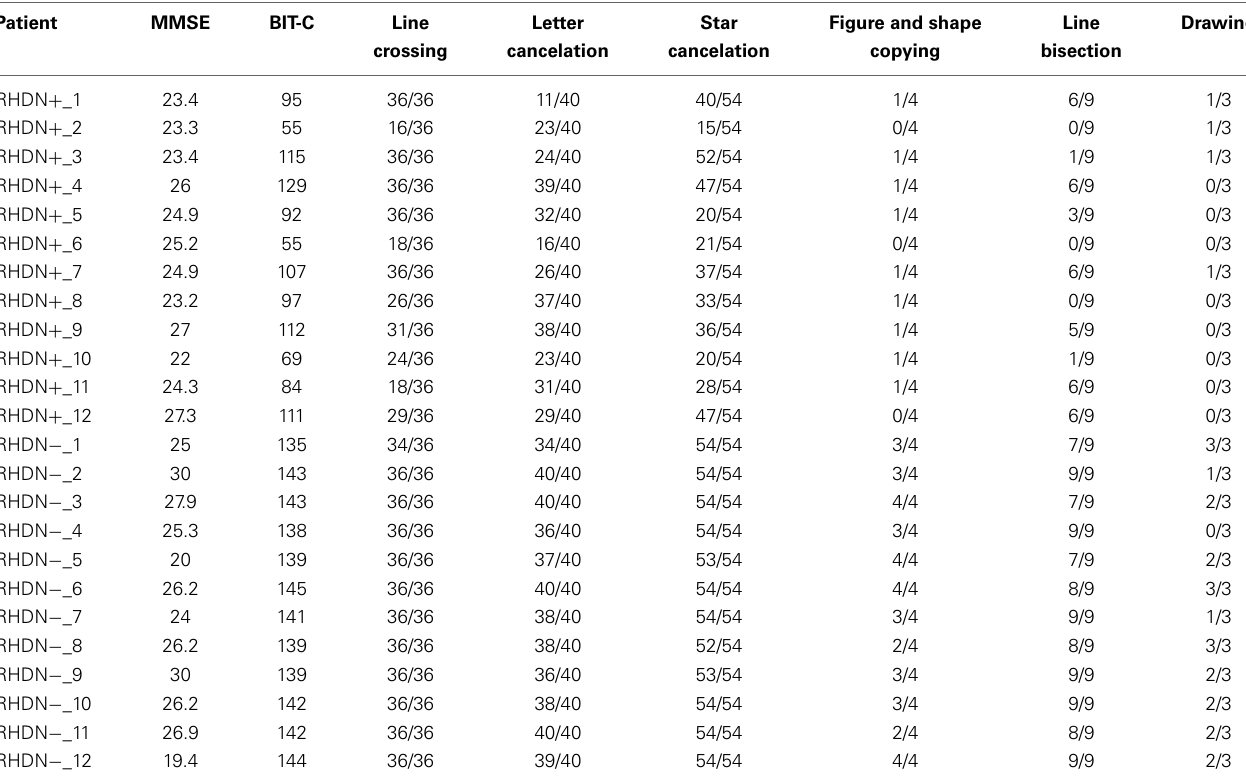
Table 2 | Patients’ performance on neuropsychological tests. Patient BIT-C Line Letter Star Figure and shape Line Drawing crossing cancelation copying